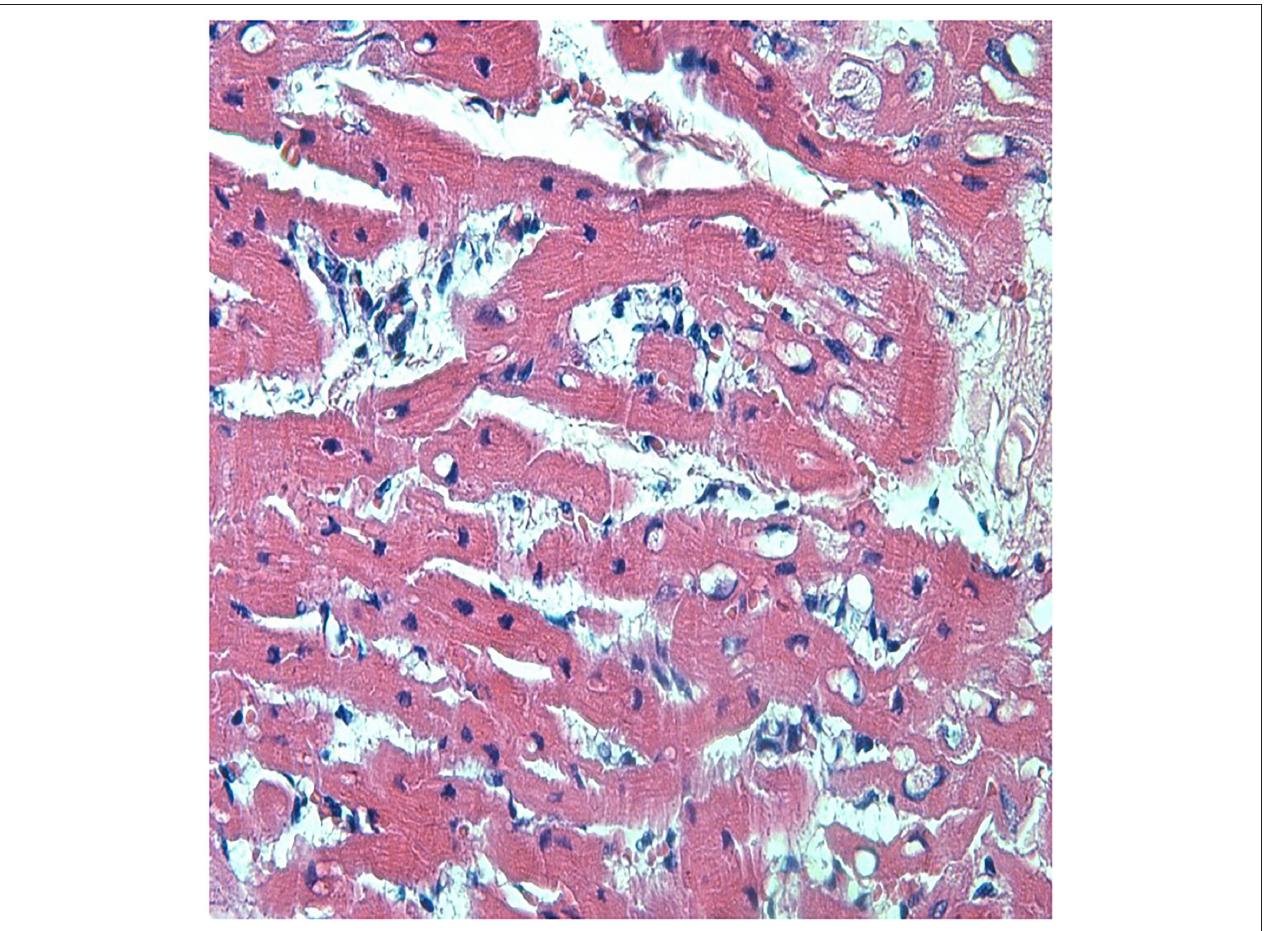
FIGURE 4 | Left ventricle from a rabbit from the VG showing severe and diffuse congestion, with lymph-histiocytic infiltrate near blood vessels. Discrete multifocal cardiomyocyte degeneration was also observed. This rabbit did not partake the trial period and was inoculated with venom only accompanied by adjuvant (HE, 400X). P.A.S. stain was not